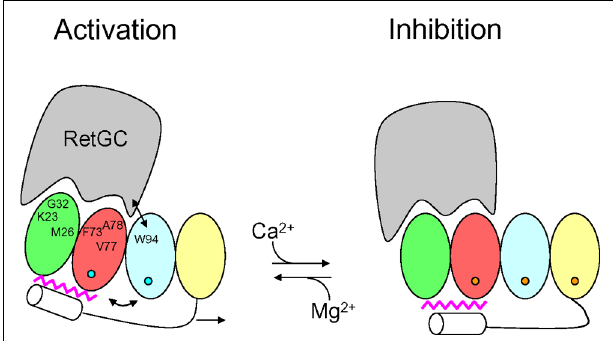
FIGURE 4 | Schematic diagram of retinal guanylyl cyclase activation by GCAP1. RetGC is shown in gray.The four EF-hands in GCAP1 are colored coded as defined in Figure 1 , bound Mg 2 + are depicted by blue circles, bound Ca 2 + are orange circles, the C-terminal helix is white, and N-terminal myristoyl group is magenta.The labeled GCAP1 residues (K23, M26, G32, F73,V77, A78, andW94) have been implicated in the RetGC binding site (Lim etal., 2013; Peshenko etal., 2014).The binding of Ca 2 + at EF4 causes conformational changes that are transmitted to the RetGC binding site by a Ca 2 + -myristoyl tug mechanism (see arrows) modified from Peshenko etal.